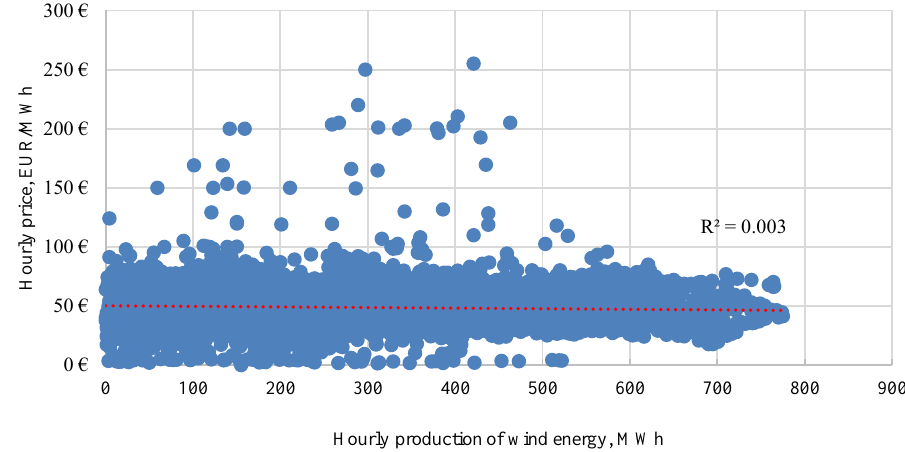
Fig. 2. Correlation between wind power production and power market price on hourly basis in Baltic region during 2019 (Data source: Nord Pool